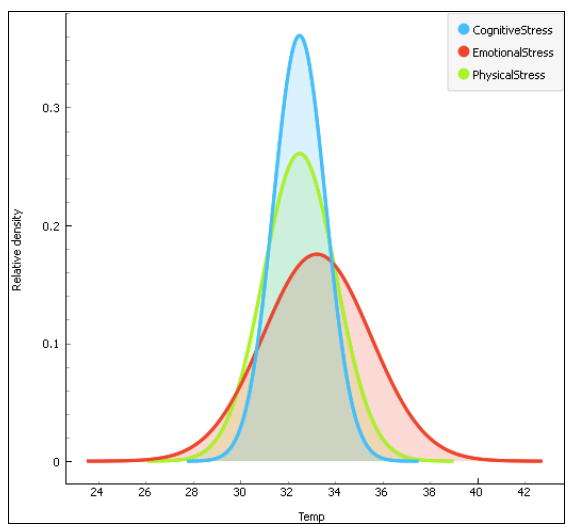
Figure 5. The distribution of the temperature data(Temp) according to the three stress types.